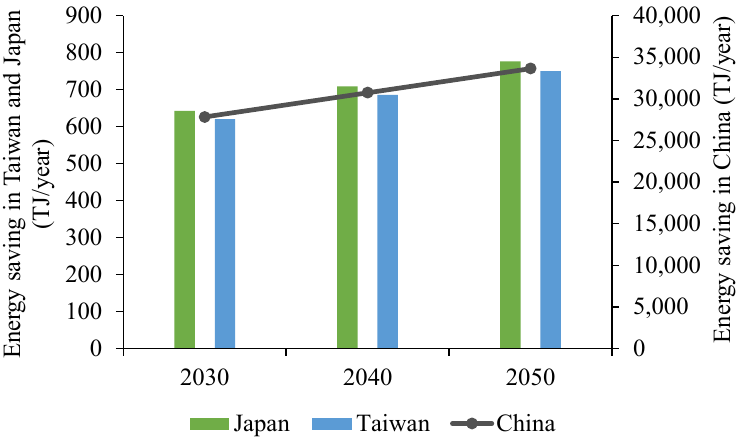
Figure 16. Total annual final energy savings after electrification of the dyeing process.